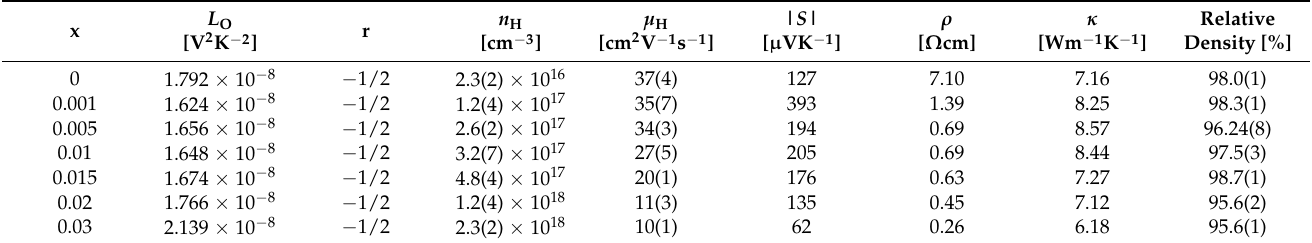
Table 2. Summary of thermoelectric properties of β -Fe 1 − x Ni x Si 2 (0 ≤ x ≤ 0.03) at 300 K, where L O , r = − 1/2, n H , µ H , S , ρ , and κ are Lorenz number, scattering factor (for acoustic phonon scattering), carrier density, mobility, Seebeck coefficient, electrical resistivity, and thermal conductivity,